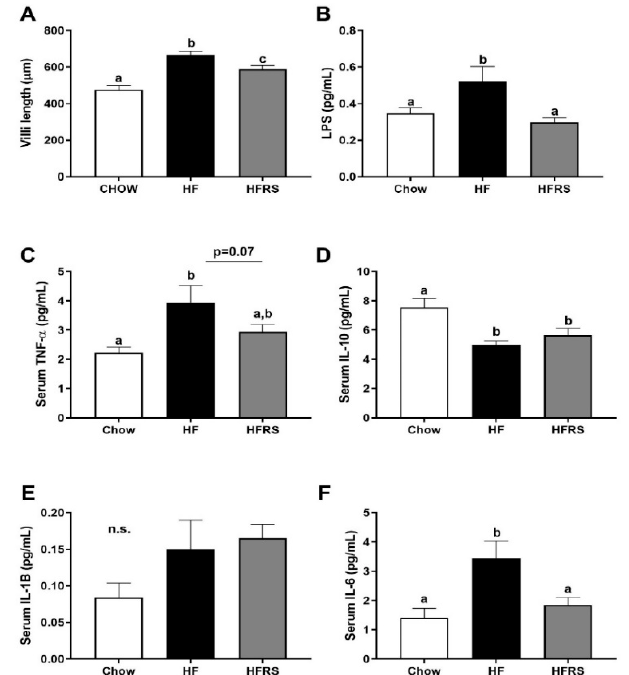
Figure 3. Potato RS attenuates GI hypertrophy and systemic inflammation. The HF diet increased villi length compared to chow control which were reduced in RS supplemented rats ( A ). The HF feeding led to a significant increase in pro-inflammatory LPS circulating levels, which was normalized by RS supplementation ( B ). Similarly, HF-diet driven increases in circulating TNF α ( C ) and IL-6 ( F ) were reduced in HFRS rats. Both HF and HFRS animals display a significant decrease in circulating IL-10 ( D ). There were no di ff erences among groups in serum IL-1 β ( E ). LPS = lipopolysaccharides, TNF α = tumor necrosis factor-a, IL-10 = interleukin 10, IL-6 = Interleukin 6, IL-1 β = Interleukin 1 Beta, HF = high fat, HFRS = high-fat resistant starch, all significance determined at p < 0.05. n = 8 per group. Data are presented as the mean ± SEM; a, b, c di ff erent letters indicate statically significant di ff erences among